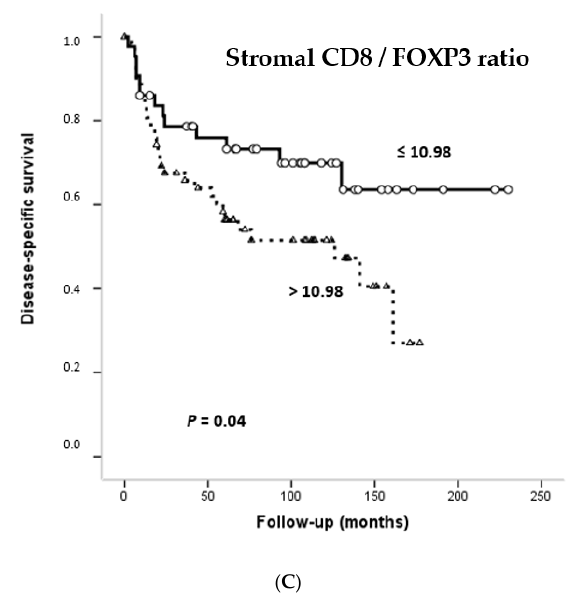
Figure 2. Kaplan-Meier disease-specific survival curves in the cohort of 125 OSCC patients categorized by stromal FOXP3 + ( A ), tumoral FOXP3 + ( B ) or stromal CD8 + /FOXP3 + ratio ( C ). Median values were used as cut-off points. p values were estimated using the log-rank